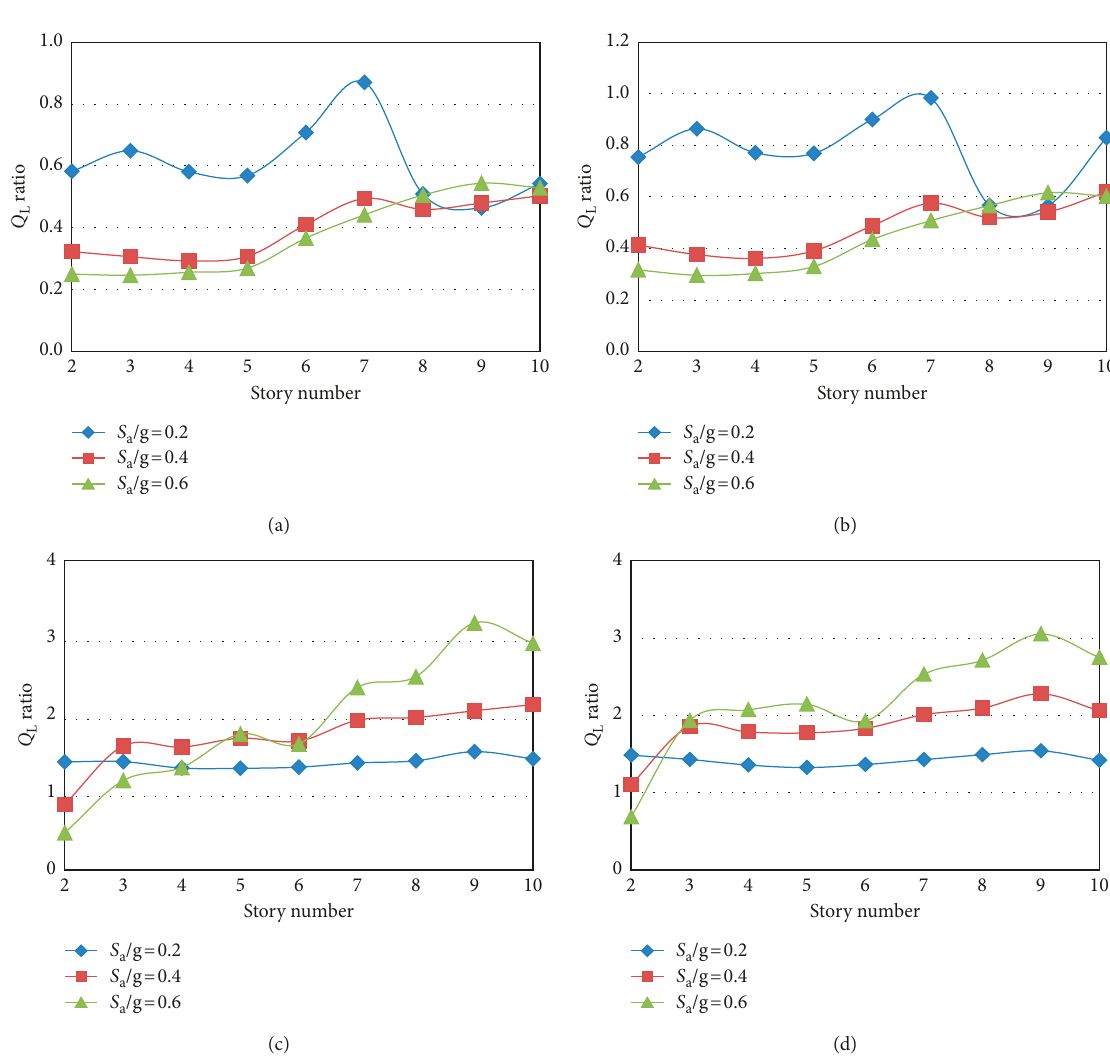
Figure 5: Q L ratio, 10-level building: (a) beams NS; (b) beams EW; (c) columns NS; (d) columns EW.